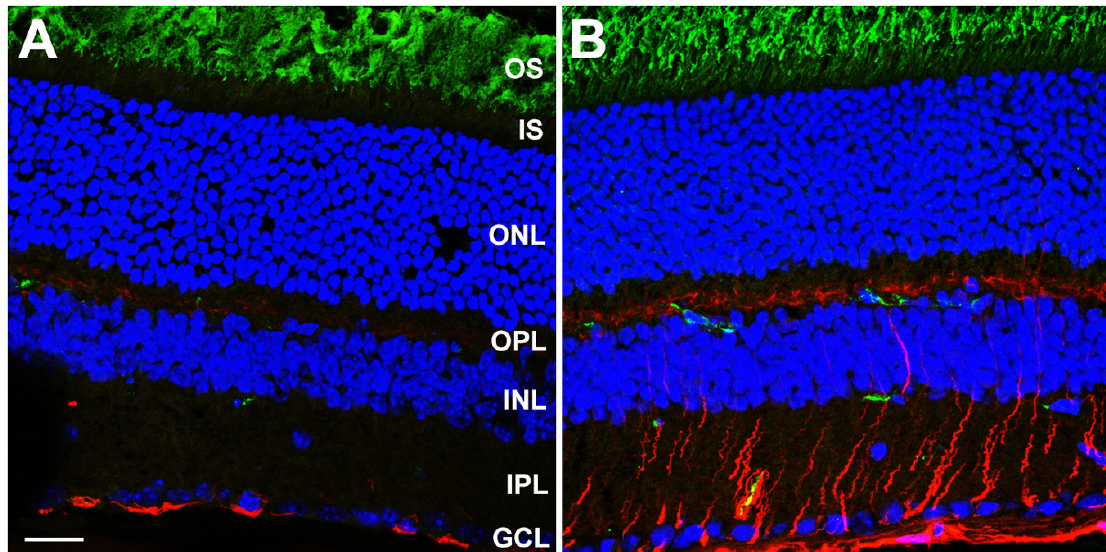
Figure 4. Laser confocal microscopy images of ( A ) WT control and ( B ) Dhdds K42E/K42E mouse